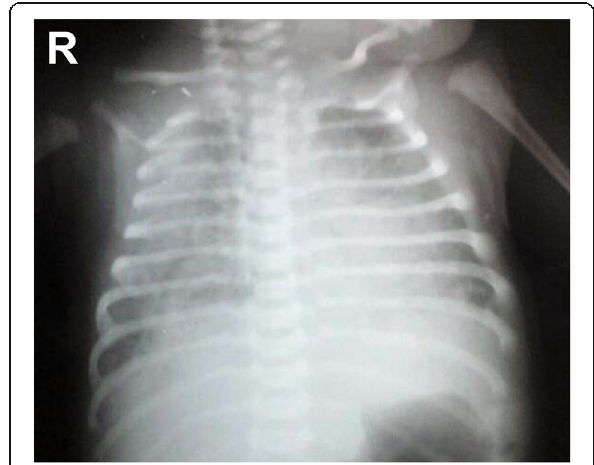
Fig. 1 Chest radiograph of a 1-day-old neonate showing a bilateral decrease of the lung volumes with diffuse granular opacities conforming with the picture of surfactant deficiency disease